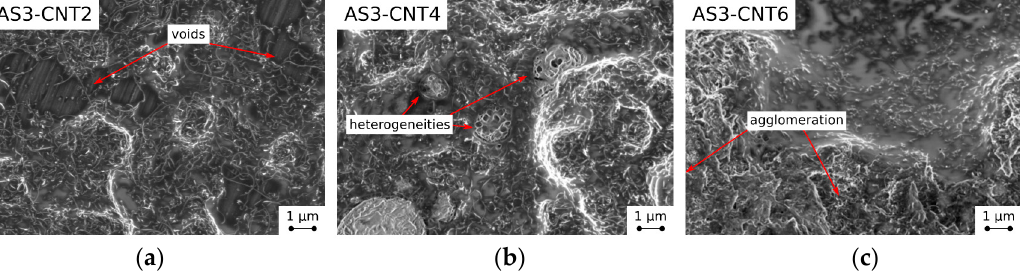
Figure 2. Top-view SEM images of CNT-silane composite film ( a ) AS3-CNT2; ( b ) AS3-CNT4; ( c ) AS3-CNT6.